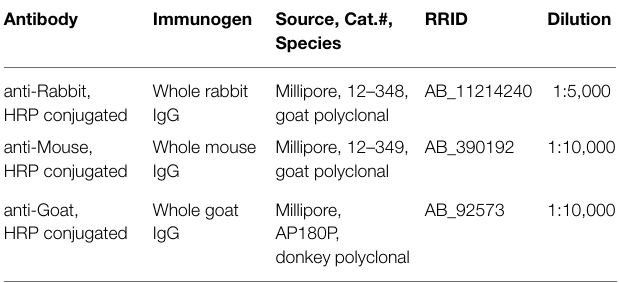
TABLE 2 | Secondary antibodies.